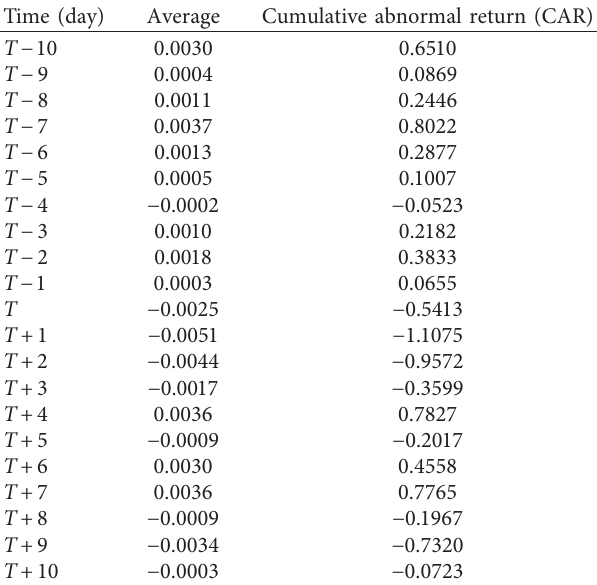
Table 3: Cumulative abnormal